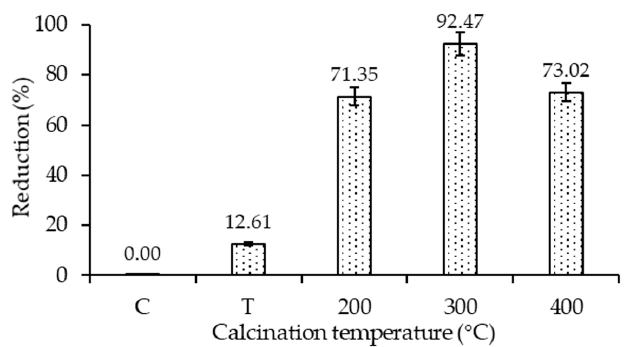
Figure 17. Antibacterial efficiency of the bare TiO 2 (T) and 20N–TiO 2 photocatalyst calcined at different calcination temperatures in 90 min of irradiation duration.